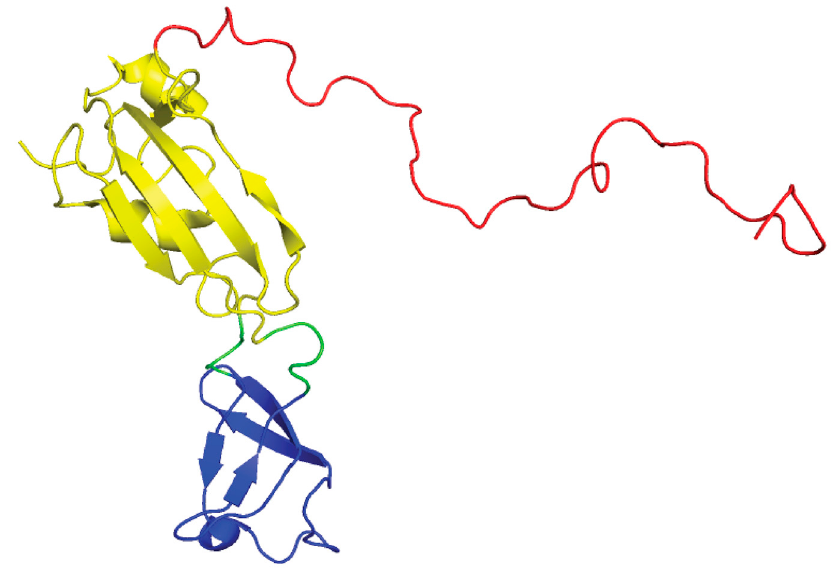
Figure 11. NMR structure of E. coli SlyD (PDB ID 2KFW) [126]. The IF domain is colored blue, the PPIase domain is colored yellow, and the unstructured C-terminal metal-binding tail is colored red. H. pylori SlyD also has a histidine and cysteine rich C-terminal tail that binds 2.4 Ni(II) per protein or 3.3 Zn(II) ions per protein with K dS of 2.74 and 3.79 μ M, respectively [132]. A SlyD homolog